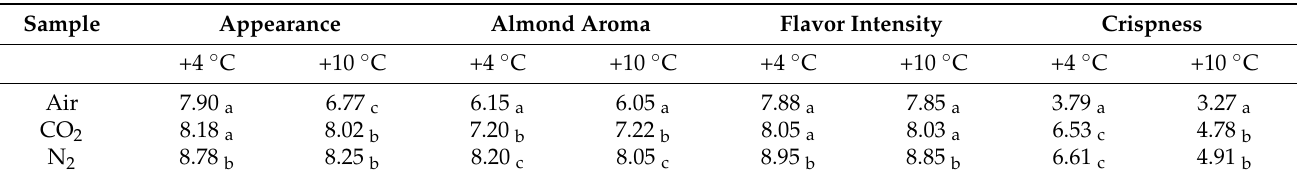
Table 2. Sensory evaluation of almonds submitted to the panelists after 12 days of storage at +4 ◦ C and +10 ◦ C,